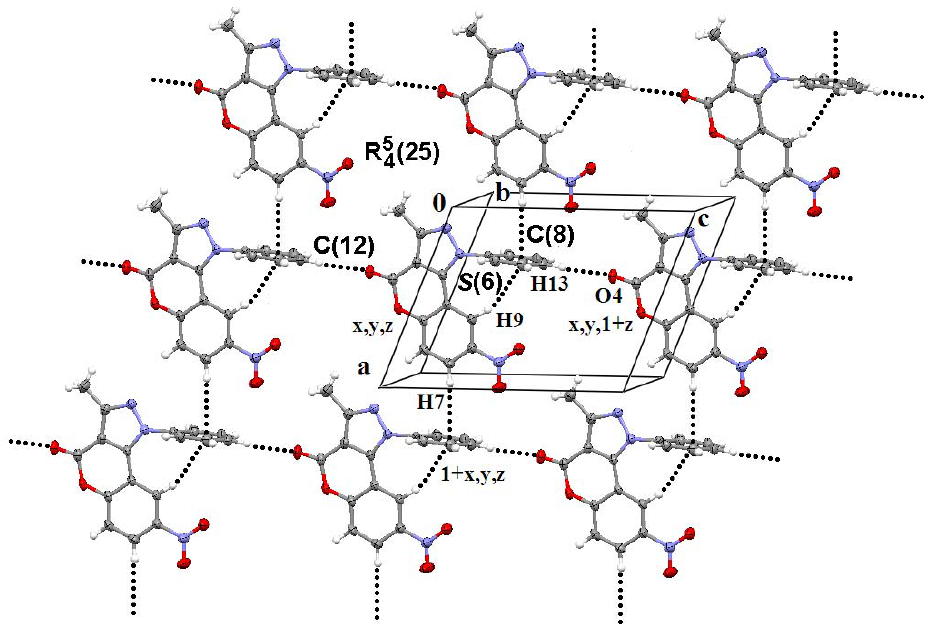
Figure 2. Supramolecular structure of compound 2d in the ac plane. S(6) intramolecular ring and C(8) chain forming bifacial C ― H··· π interactions, C(12) chain and R 5 motifs are also